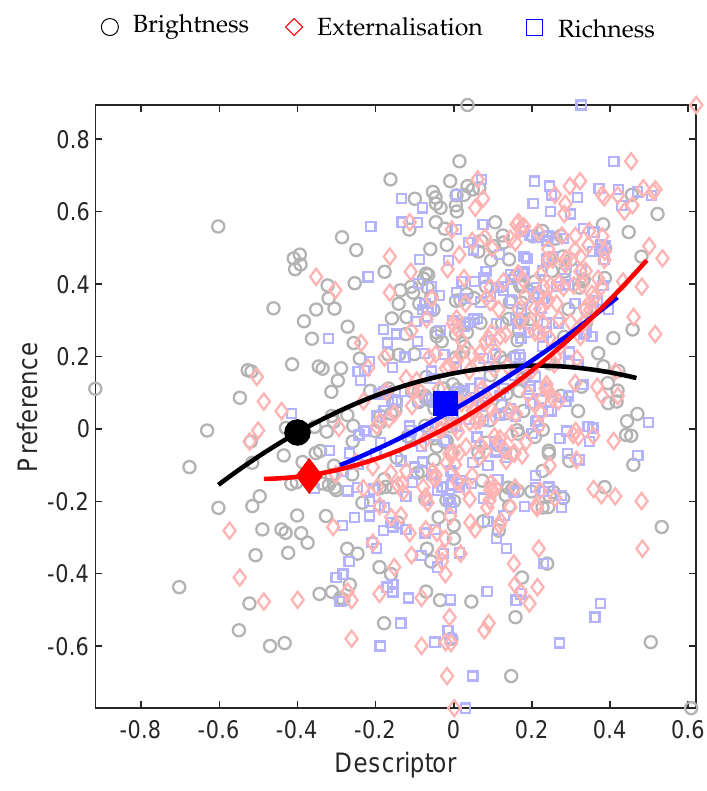
Figure 11. A comparison of the ratings given to each stimulus by each subject. Brightness, Richness and Externalisation ratings are plotted against Preference ratings to show correlation. Both Richness and Externalisation show a positive correlation whilst an overall preference for a more natural Brightness is indicated. Note that outliers have been excluded from this